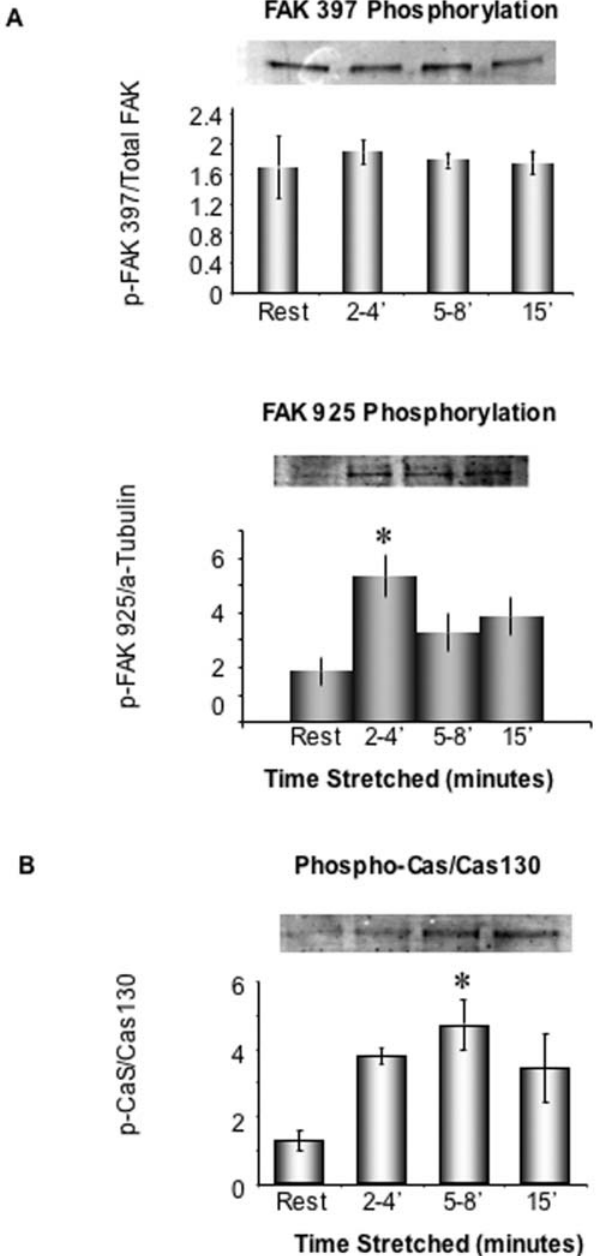
Figure 5. Identification of p125 as FAK and p130 as Cas. A. Stretch selectively activates FAK at tyrosine site 925, not site 397. Term pregnant uterine smooth muscle strips were unstretched or stretched to 2x slack length at indicated time period. The tissue homogenates were probed with FAK site-specific antibodies. Phospho- FAK signals are normalized to the total FAK protein or alpha-Tubulin. *p , 0.05 compared to unstretched control samples (by ANOVA). n=3–5 in each group. Typical blots were shown on the top. Both FAK total protein antibody and FAK-Y925 phospho antibody are rabbit polyclonal antibodies, thus, a-tubulin mouse monoclonal antibody was chosen for normalization of the FAK-Y925 signal. B. Stretch activates pCas130. Phospho-Cas signals are normalized to Cas protein levels and expressed as p-Cas/Cas ratios. *p , 0.05 compared to unstretched control samples (by ANOVA). n=3–5 samples in each